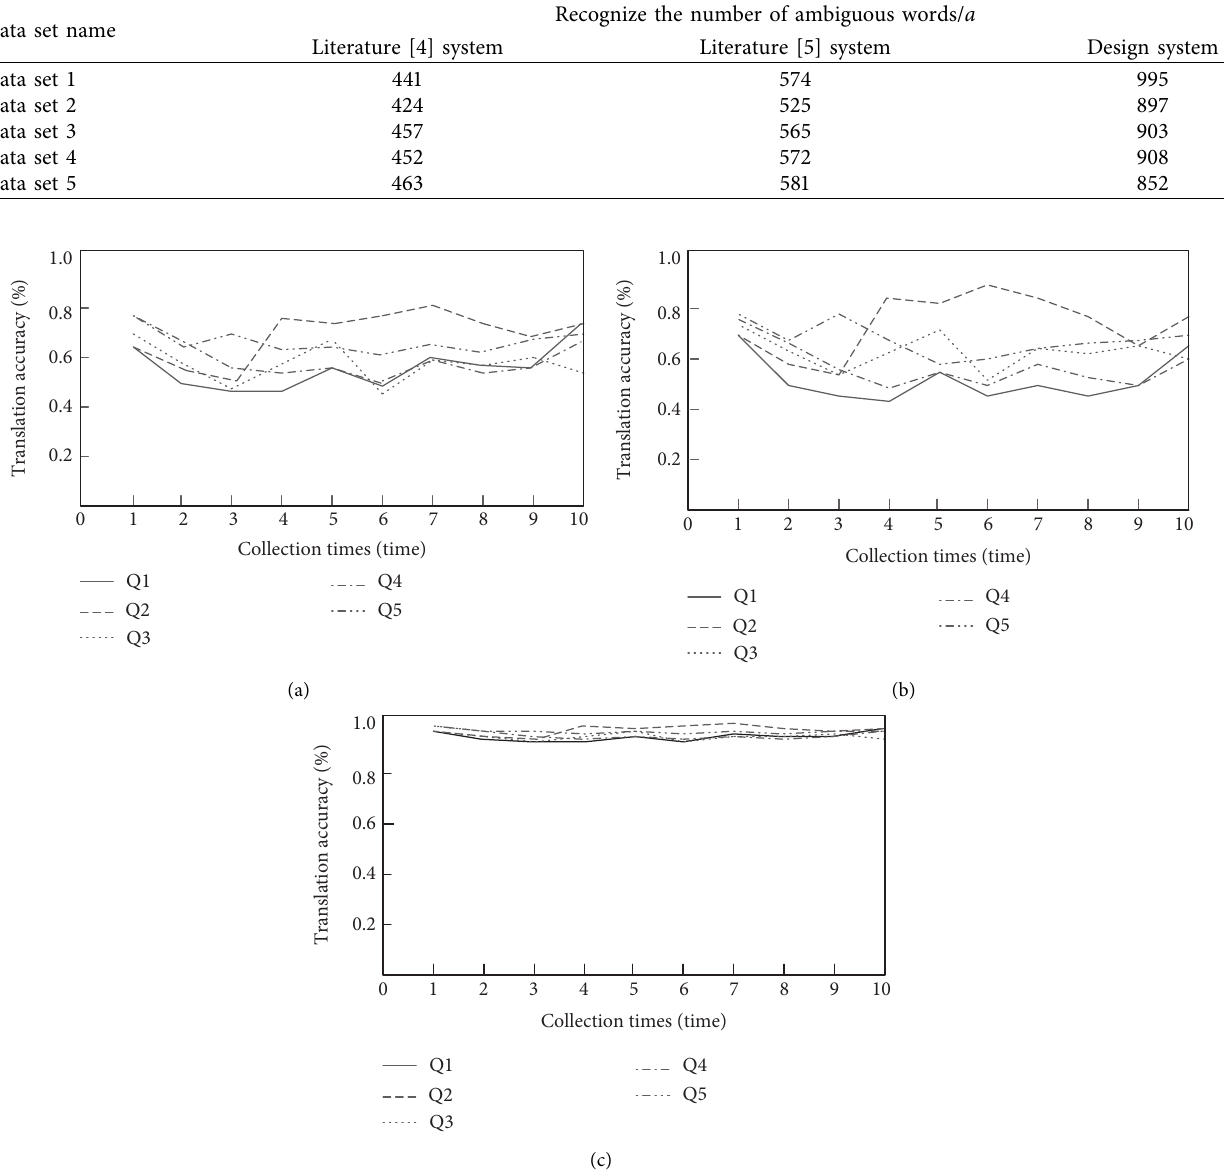
Figure 8: Comparison and analysis of translation accuracy of three Chinese-English wireless simultaneous interpretation